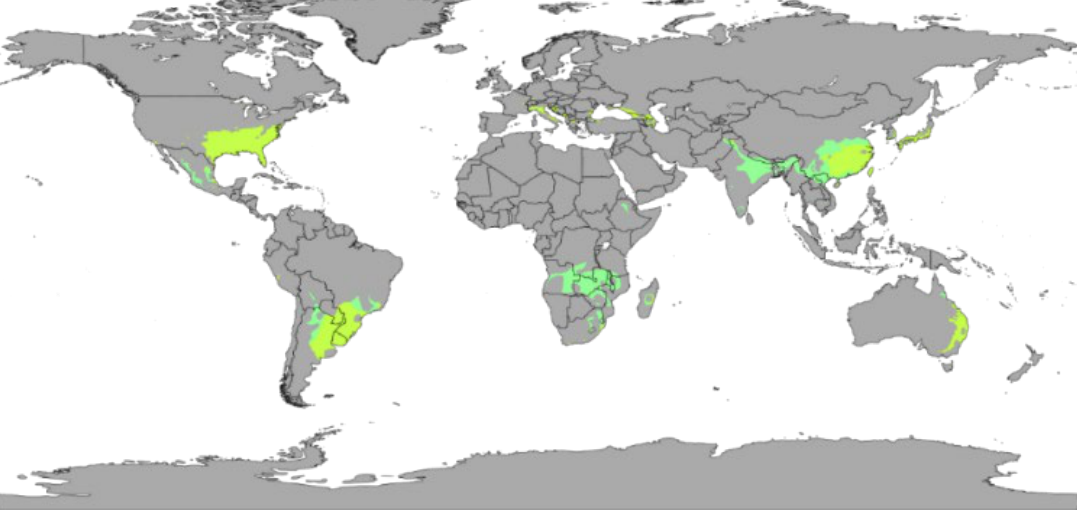
Figure 4. Humid subtropical climate Cfa and Cwa around the world